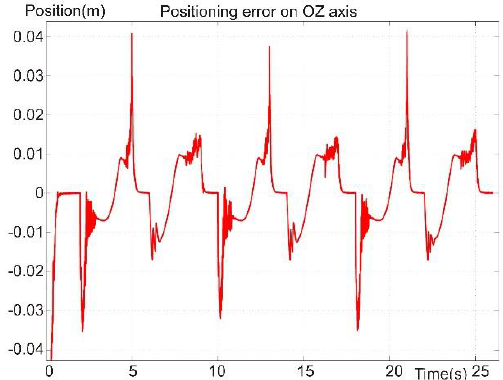
Figure 21. Foot positioning error on the OZ axis.